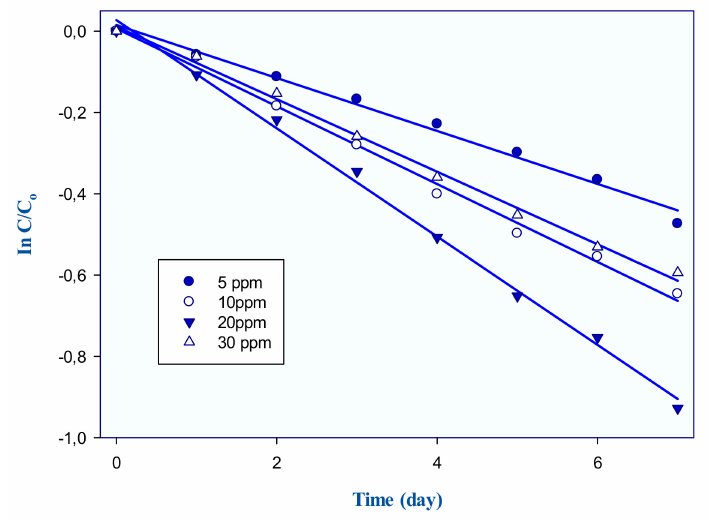
Figure 1. Constant rate of boron for each boron